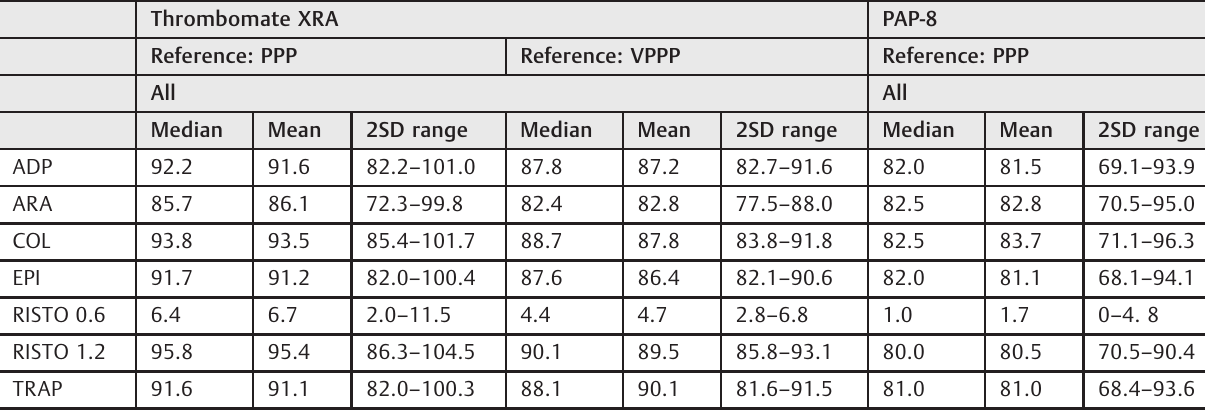
Table 2 Reference ranges for MA%. All healthy individuals ( n ¼ 100)